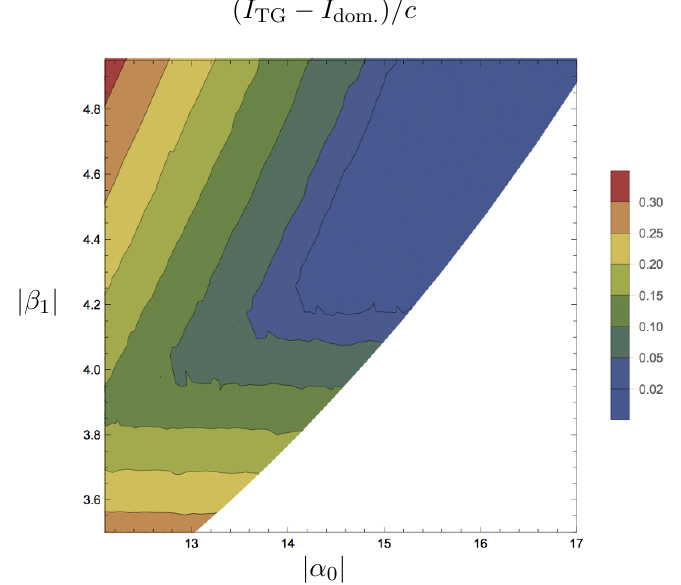
Figure 24 . Phase diagram for T j 0 i . In the blue region I TG (cid:0) I dom. vanishes and the toroidal geon phase is dominant. Outside of this region an AdS phase is dominant. In the white region we have no data, as it is numerically di(cid:14)cult to